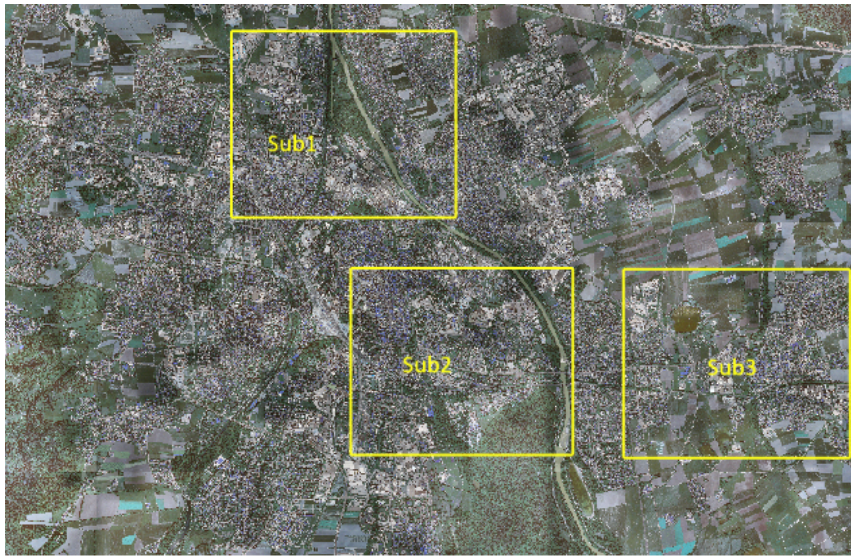
Figure 3. Three manually labelled subregions.